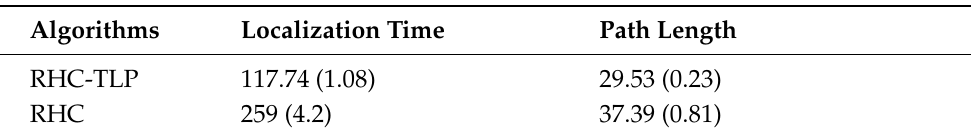
Table 2. Average (Standard error) results for localization time (s) and path length (m) in light of 30 runs for Case